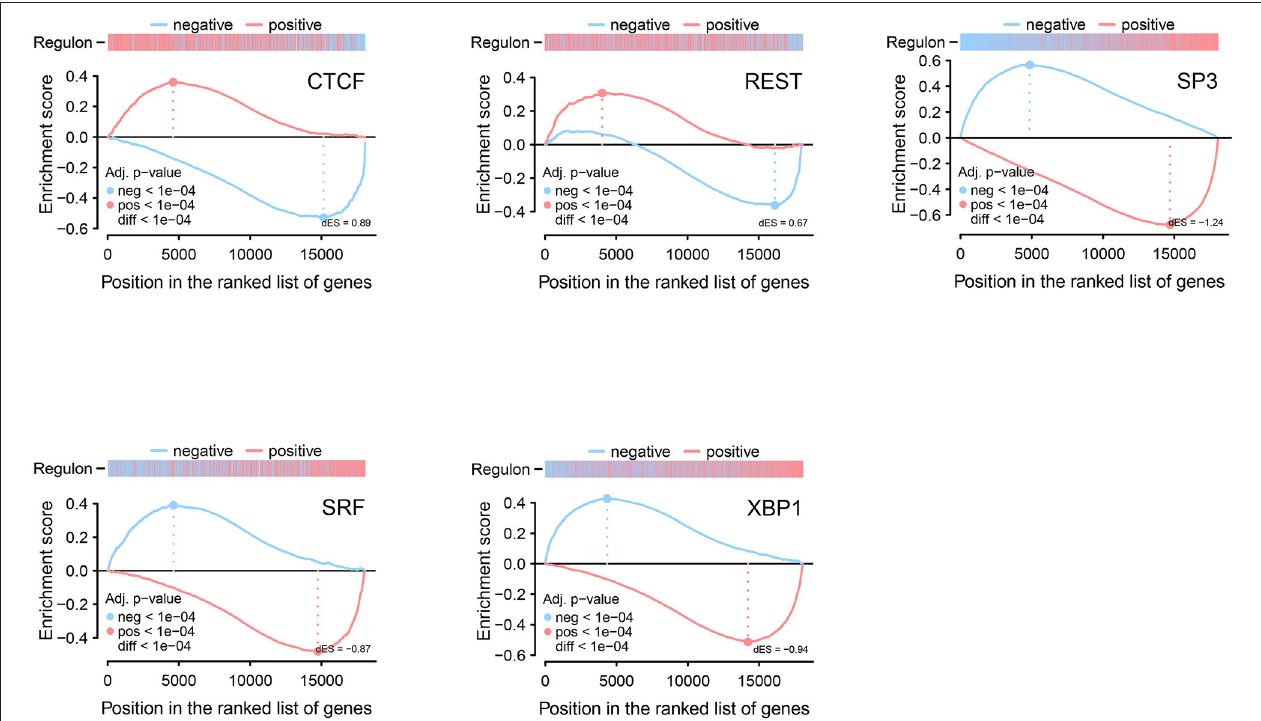
FIGURE 3 | Two-tailed GSEA illustrating five significant identified regulons from regulatory network analysis. Regulons are split into positive and negative targets, and differential enrichment score (dES) is shown for positive (red line) and negative (blue line)